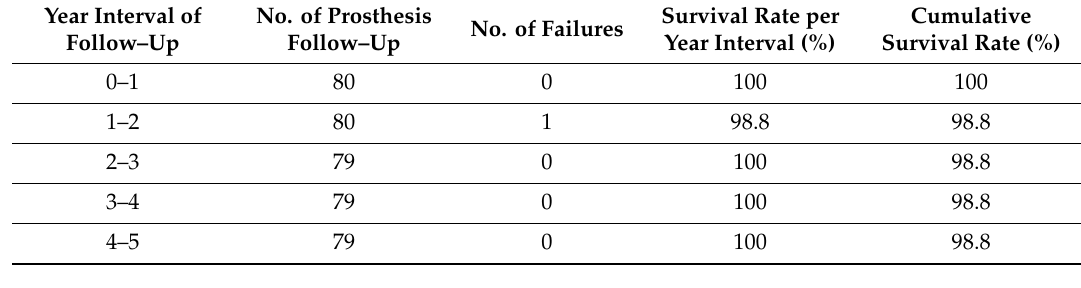
Table 11. Life table on prostheses level.